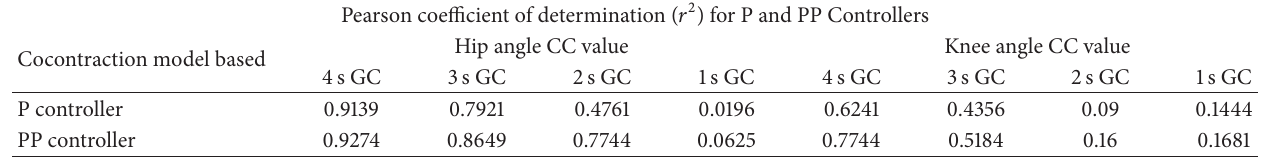
Table 4: Pearson coefficient of determination ( 𝑟 2 ) for co-contraction model based P and PP controllers. Pearson coefficient of determination ( 𝑟 2 ) for P and PP Controllers Cocontraction model